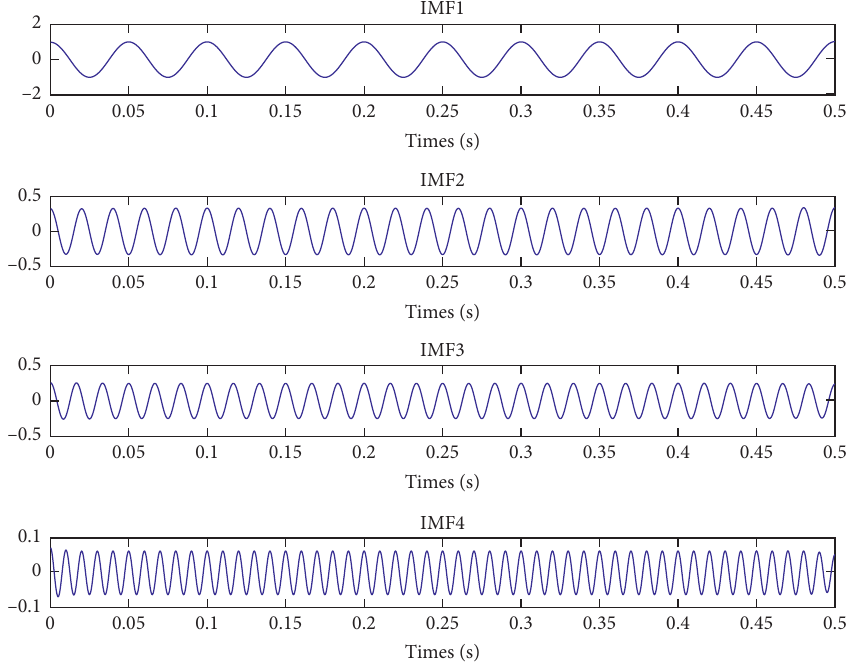
Figure 7: Decomposition results of the simulated signal.